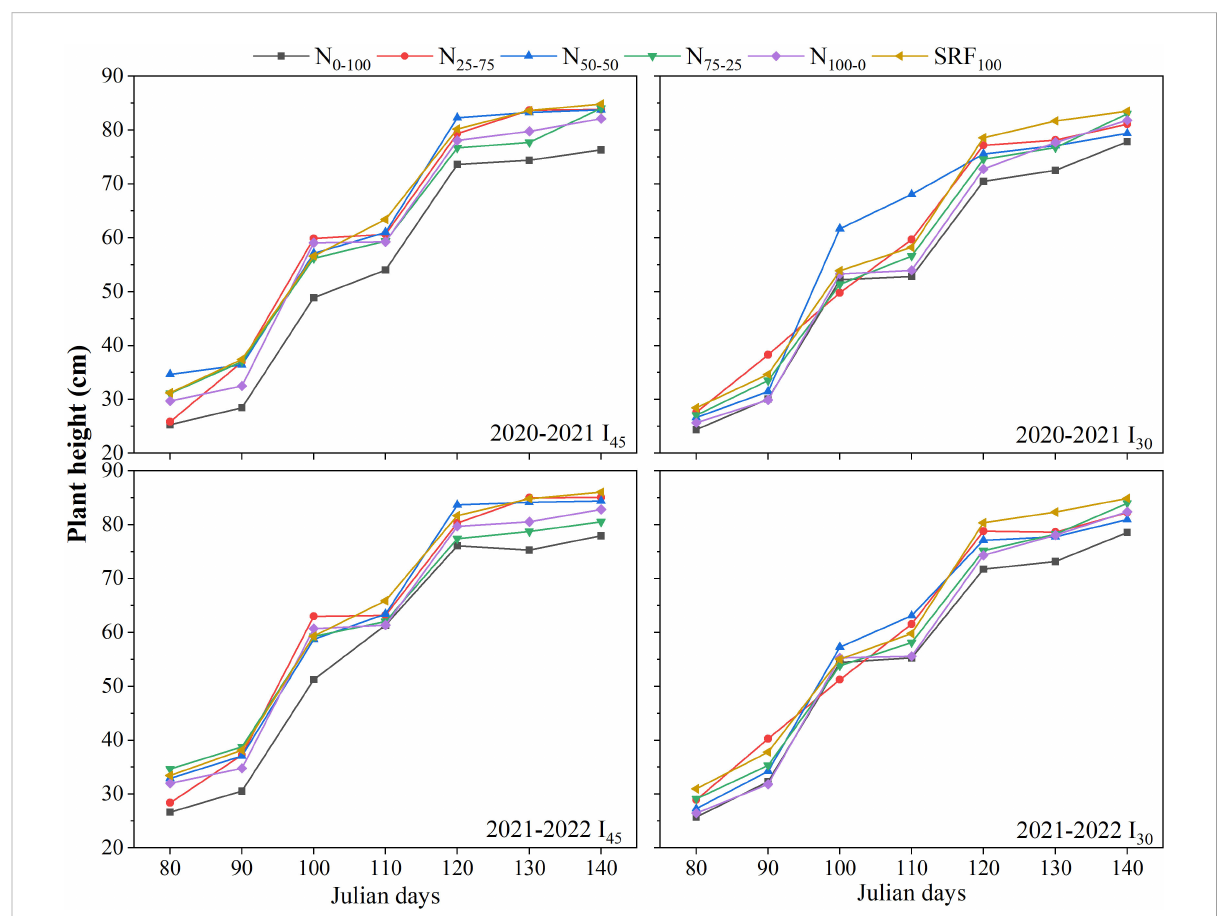
FIGURE 2 Variation of plant height under different irrigation scheduling and nitrogen application modes during 2020-2021 and 2021-2022 winter wheat- growing